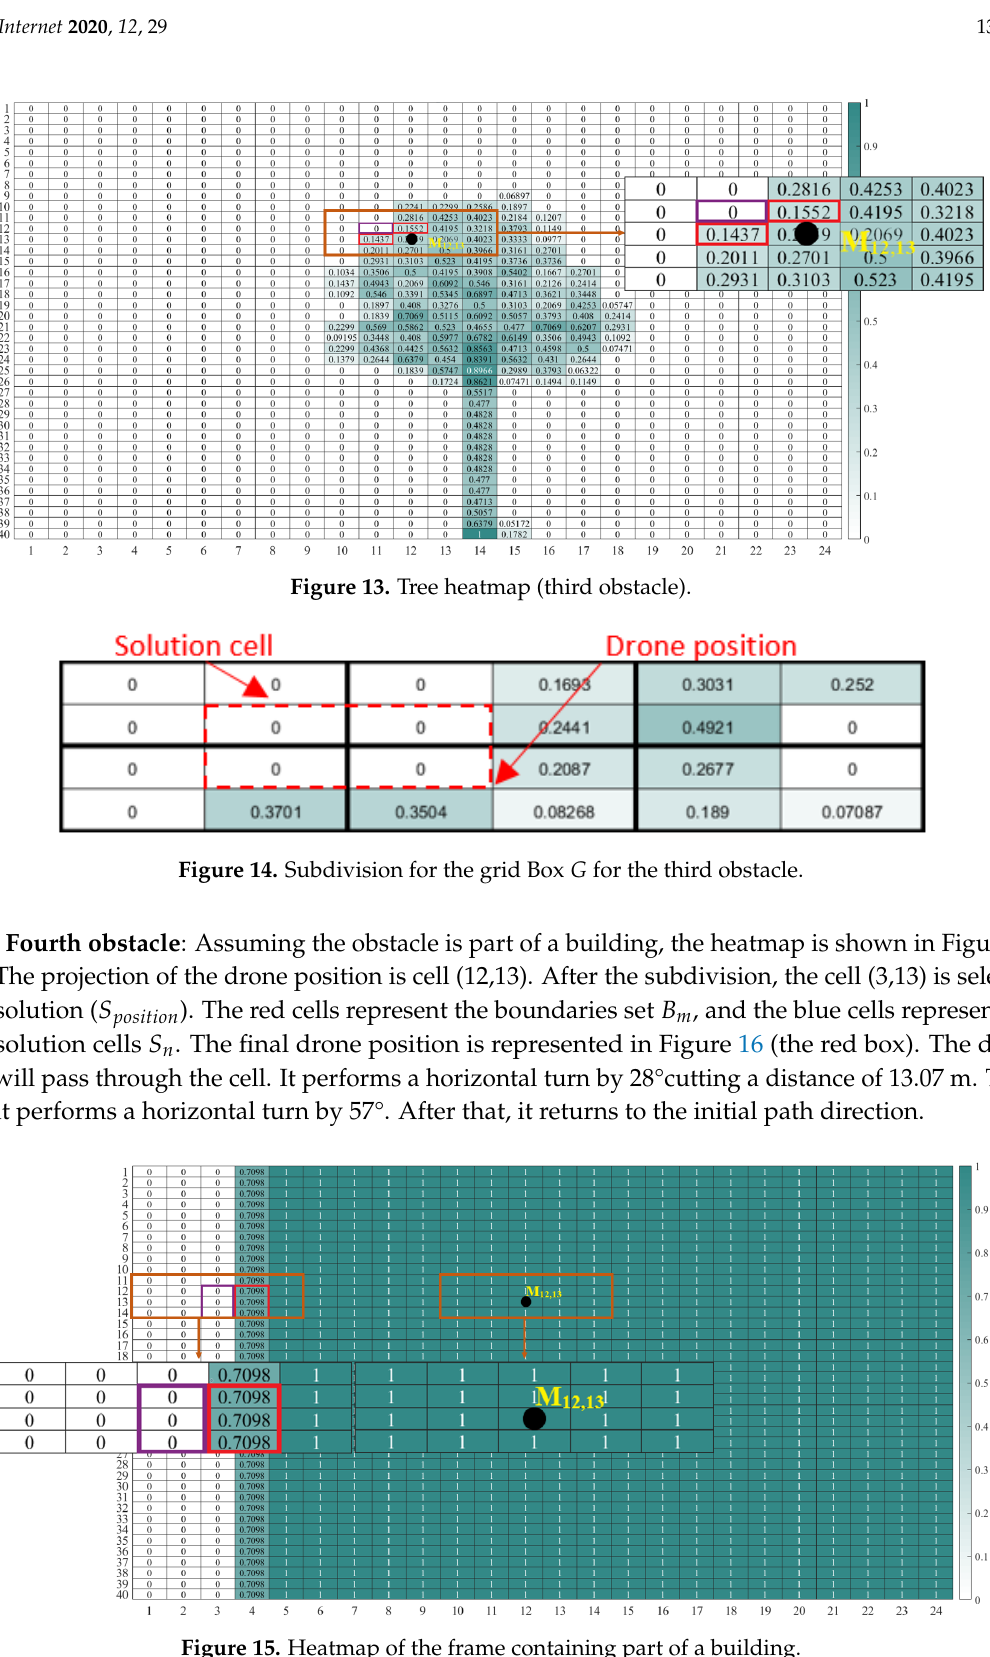
Figure 15. Heatmap of the frame containing part of a